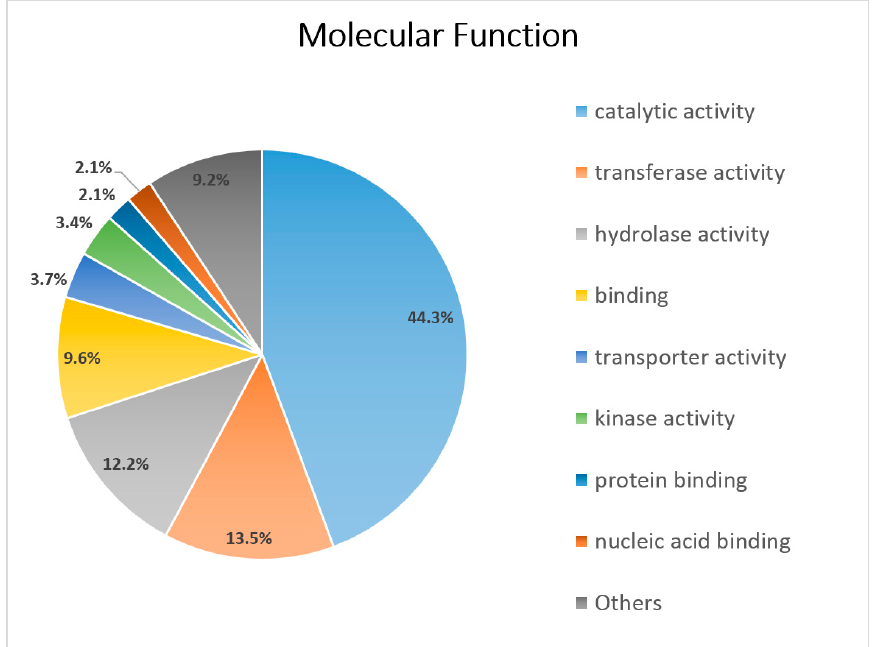
Figure 5. Subcategories of GOs identified by CateGOrizer within the Molecular Function over the whole set of predicted genes.